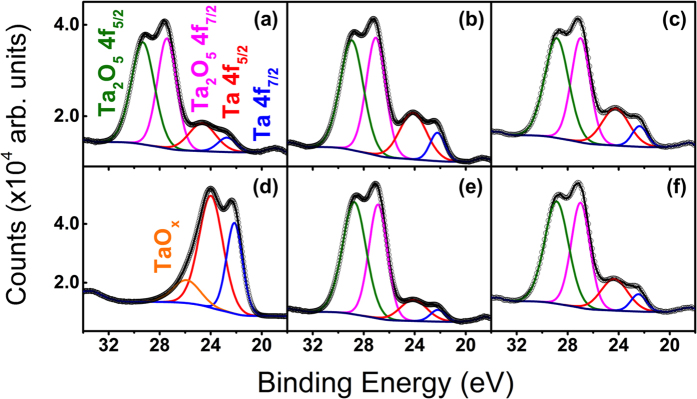
XPS region spectra of the Ta 4f doublet peak at different conditions: (a) virgin, before sputter-cleaning; (b) 823 K, 4.3 × 1024 ions m−2; (c) 1223 K, 4.3 × 1024 ions m−2; (d) virgin, after sputter-cleaning; (e) 823 K, 1.7 × 1025 ions m−2; (f) 1223 K, 1.7 × 1025 ions m−2.